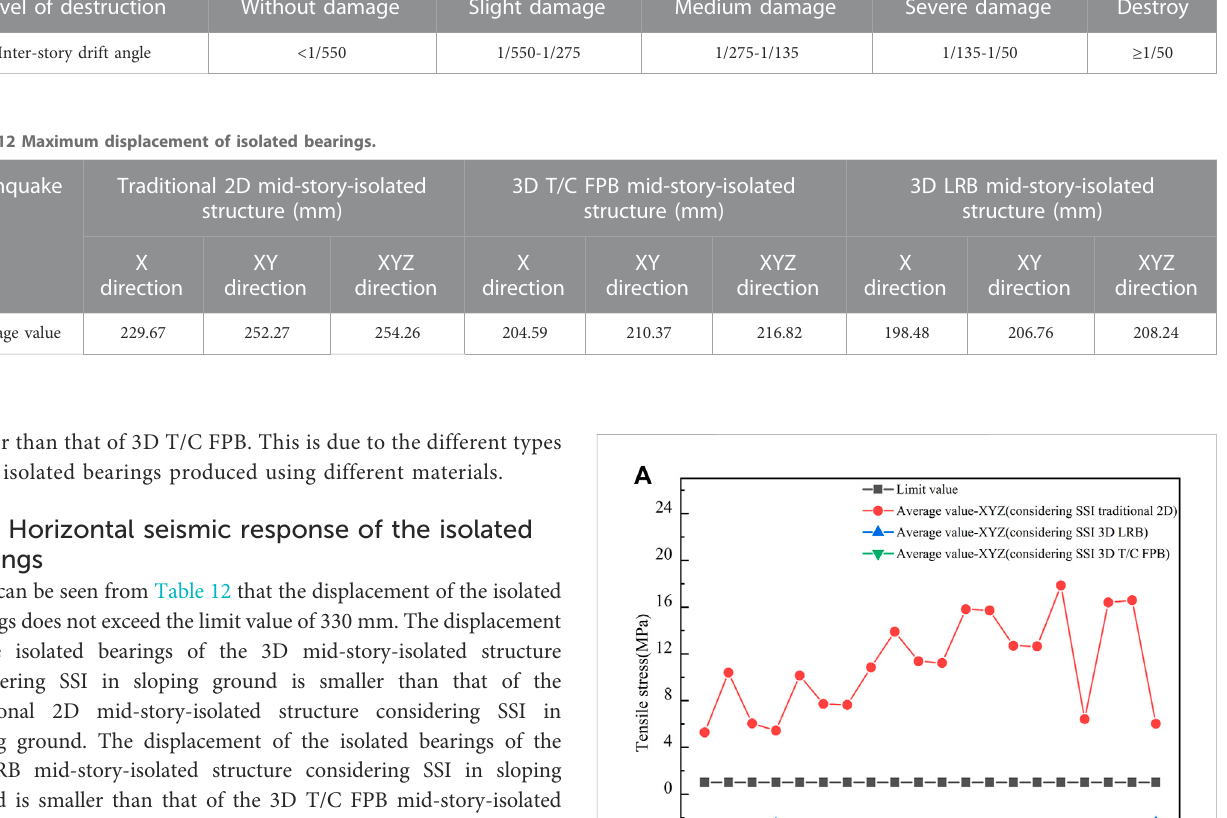
TABLE 11 Limit of the inter-story drift angle ratio. Level of destruction